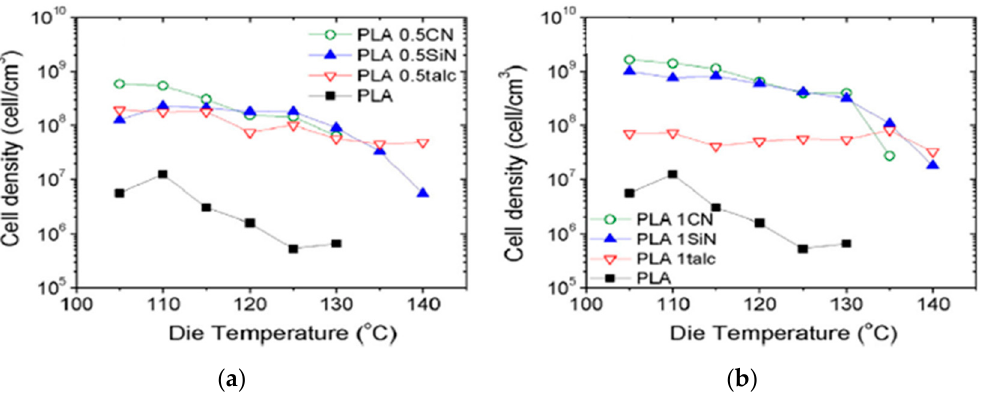
Figure 34. The cell density of foamed PLA and PLA/clay, PLA/silica, and PLA/talc composites at various die temperatures, ( a ) content of 0.5 wt% and ( b ) content of 1 wt%. Reprinted from Nofar [113]. Copyright (2020), with permission from Elsevier.